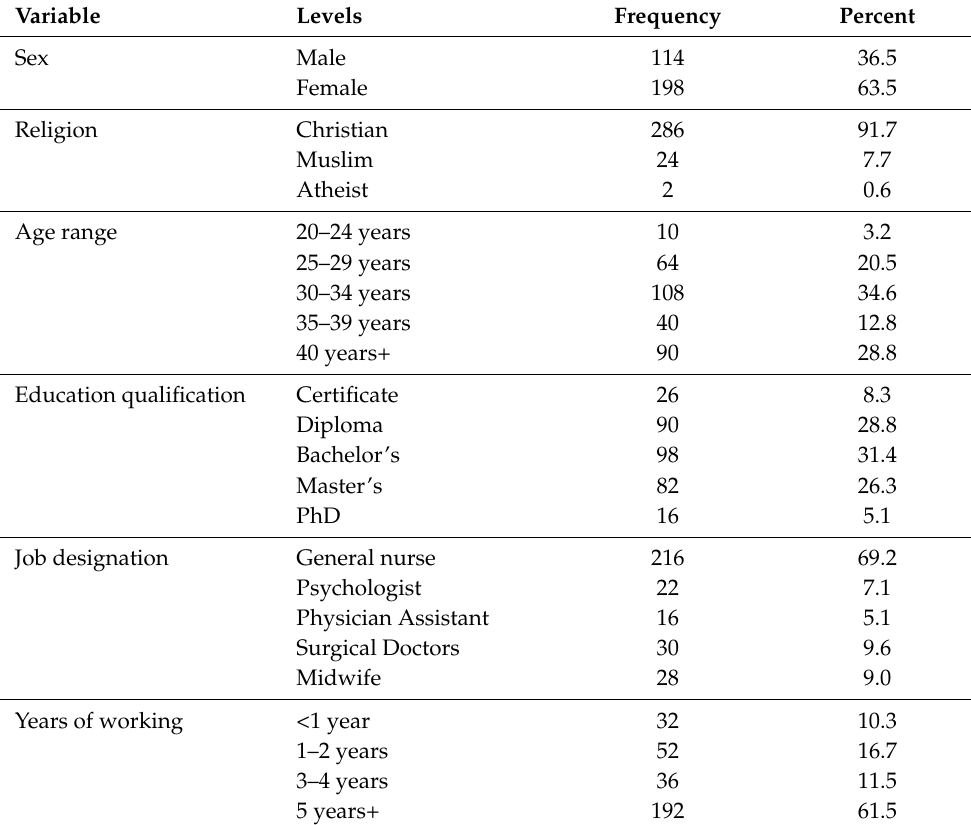
Table 1. The socio-demographic information of the